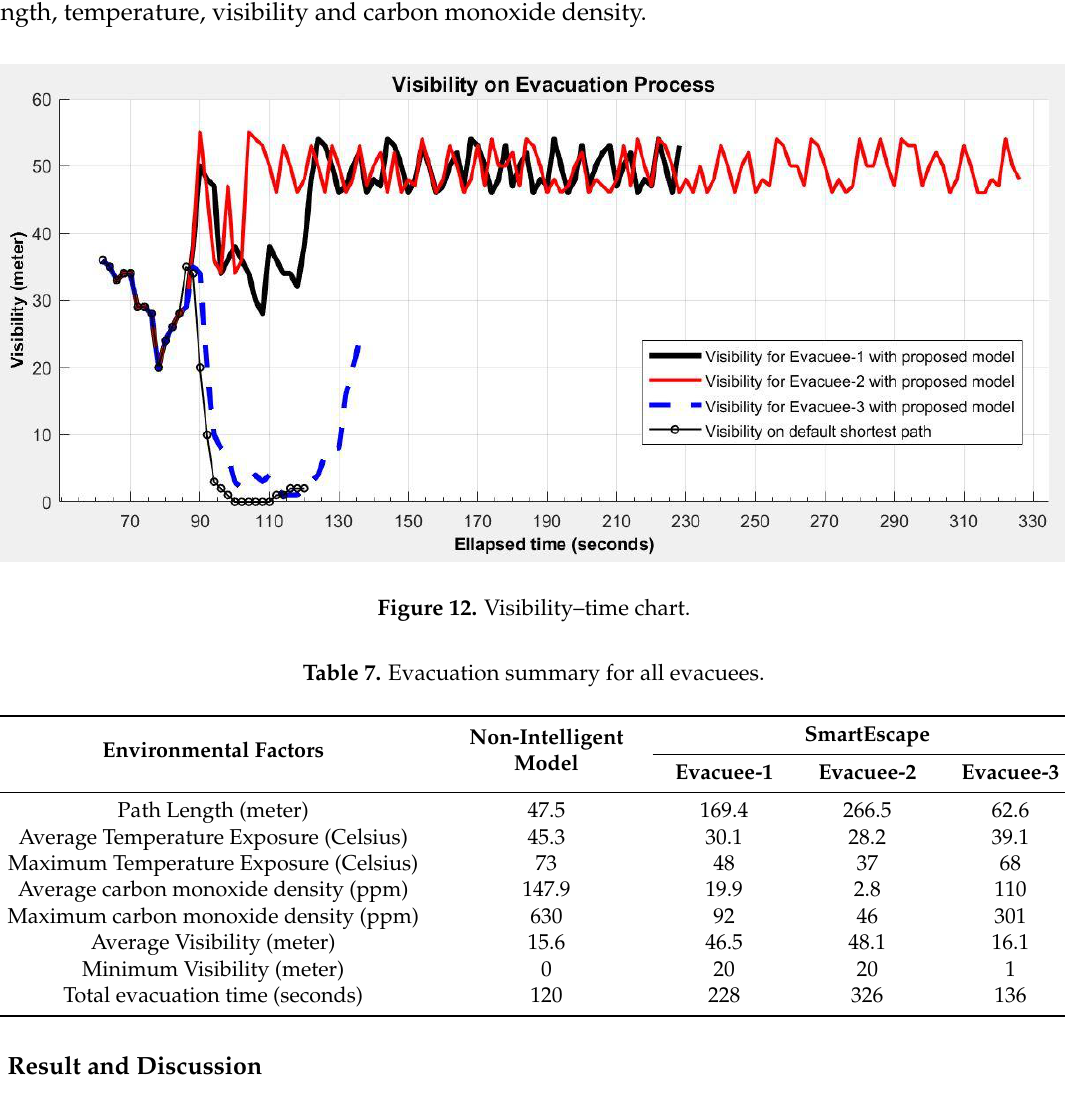
Figure 11. Carbon monoxide density–time chart.